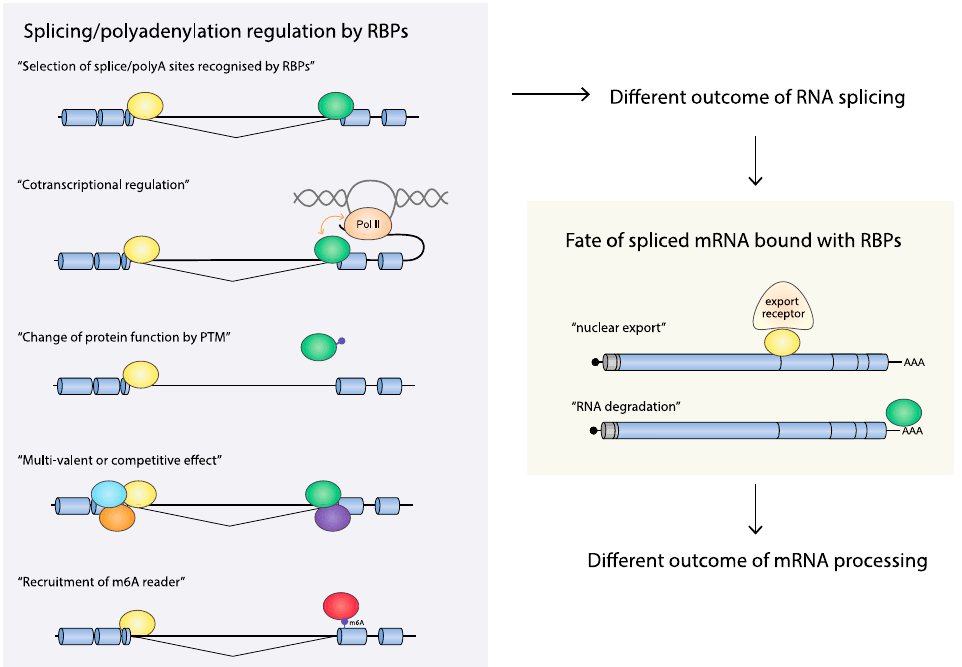
Figure 3. Consequences of RNA-binding proteins on the processing of mRNAs. (Left panel) pre-mRNAs are subject to alternative splicing and/or alternative polyadenylation controlled by interactions of the pre-mRNAs with cellular RBPs. These interactions result in the selection of appropriate splice sites or polyadenylation sites. The interactions between pre-mRNAs and RBPs can be modulated by (1) cotranscriptional regulation by altered by Pol II elongation kinetics or by interactions between Pol II and RBPs, (2) change of protein function by posttranslational modification (PTM), which is regulated by extracellular signaling and/or, for example, cellular responses to HPV infection, (3) multivalent effects and/or competition between RBPs that bind to the same or adjacent cis-acting regulatory RNA elements or hot spots for RNA-binding proteins, (4) m6A modifications on RNAs that affect recruitment of m6A readers that control RNA processing. (Right panel). Some of the RBPs may stick to the mRNAs after RNA splicing and polyadenylation. These RBPs may affect additional RNA processing steps subsequent to splicing, such as nuclear RNA export and RNA degradation.